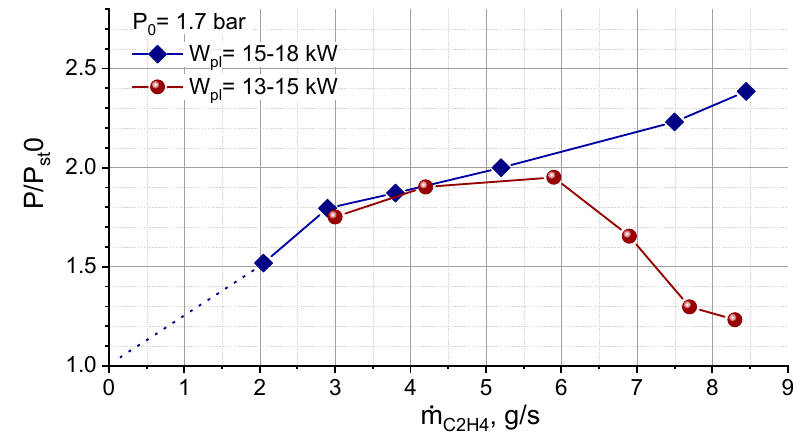
Figure 18. Pressure increase vs. fuel mass flow rate for three PIMs scheme: x = 200 mm.